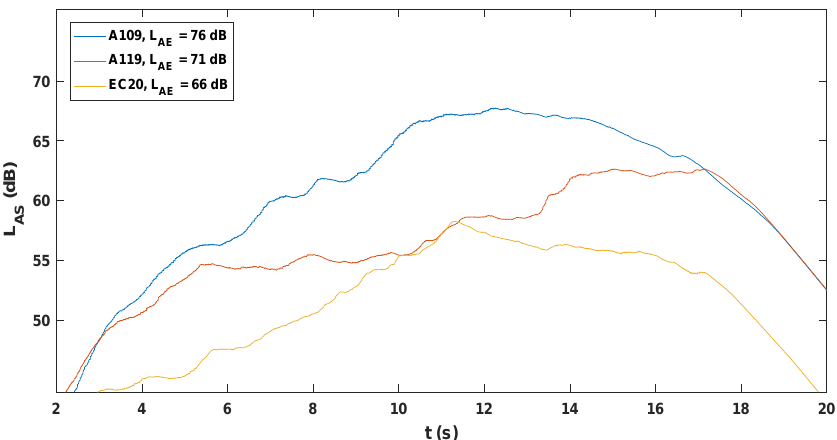
Figure 6. L AS,F as a function of time for the six flight events (no added background sounds) used in experiment 2. Helicopter type and L AE,F of each individual flight event is indicated in the